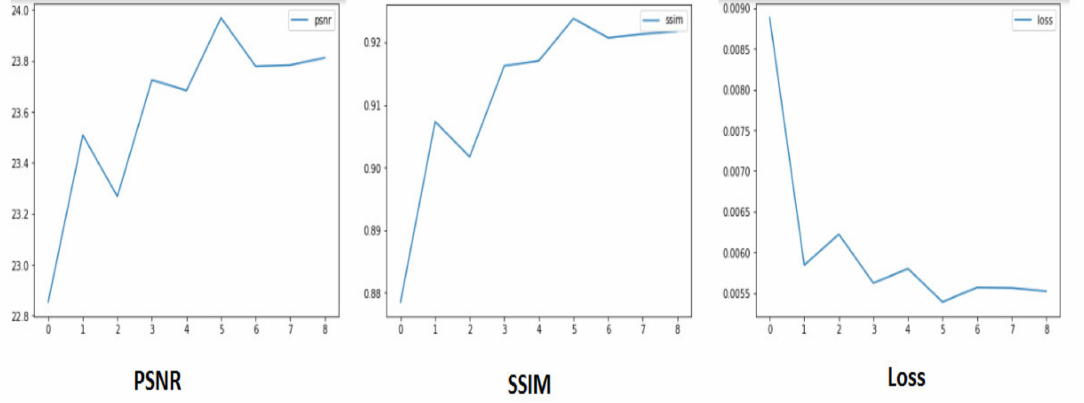
Figure 17. PSNR, SSIM, and Loss of ResNet-based CNN model.